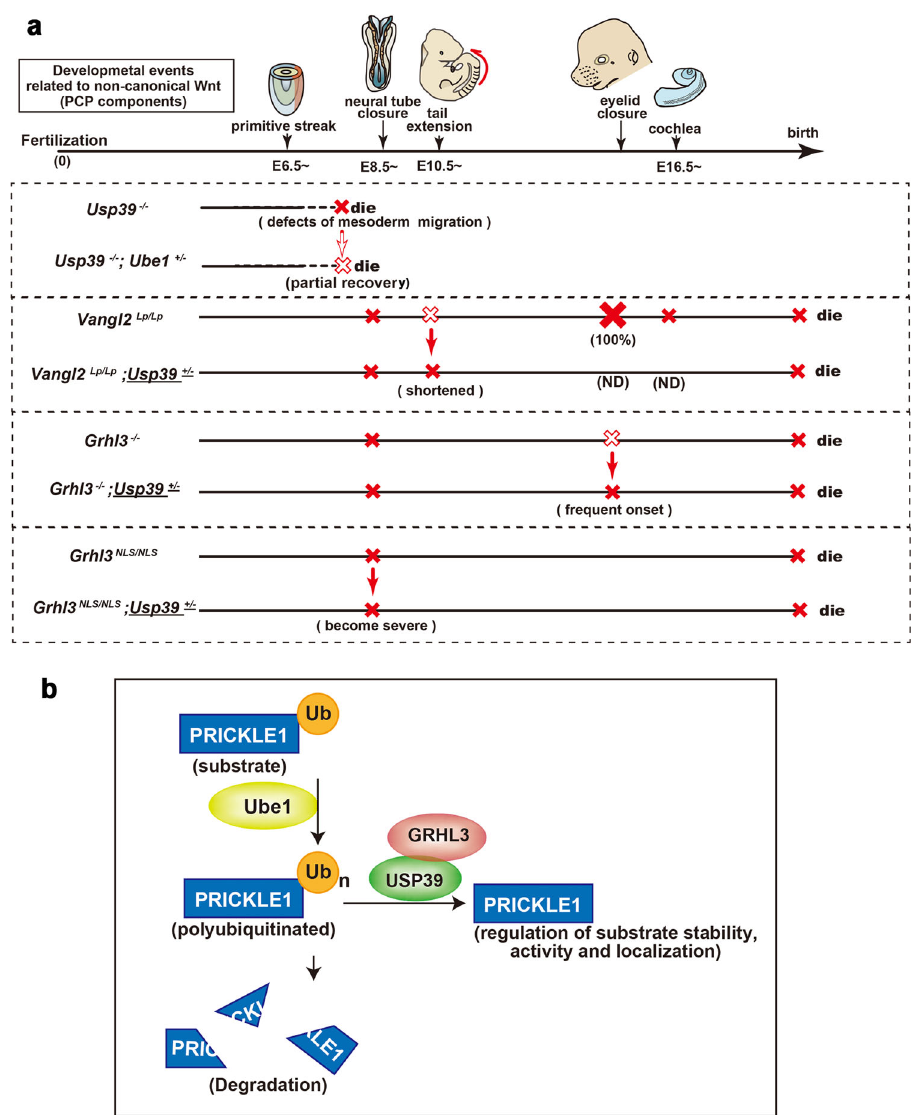
Fig. 10 Compound mutant phenotypes of Vangl2 , Grhl3, Usp39 , and Ube1 genes during mouse development and schematic model of USP39/GRHL3 complex in the de-ubiquitination pathway. a Schematic illustrations of phenotypes associated with non-canonical Wnt signaling during mouse development: solid red crosses denote defective formation with expression of complete penetrance (100%). Open red crosses denote defective formation but the penetrance is lower or the phenotype is milder. Solid arrows indicate enhancement of the penetrance or severity of defective phenotypes observed by removal of one copy of the Usp39 gene. The open arrow indicates restoration of the severity of the defect in Usp39 − / − embryos by removal of one copy of the Ube1 gene. b A schematic model representing how the GRHL3/USP39 interaction can stabilize the PRICKLE1 protein as a target of PCP-related molecules via deubiquitination. ND not determined, PCP planar cell